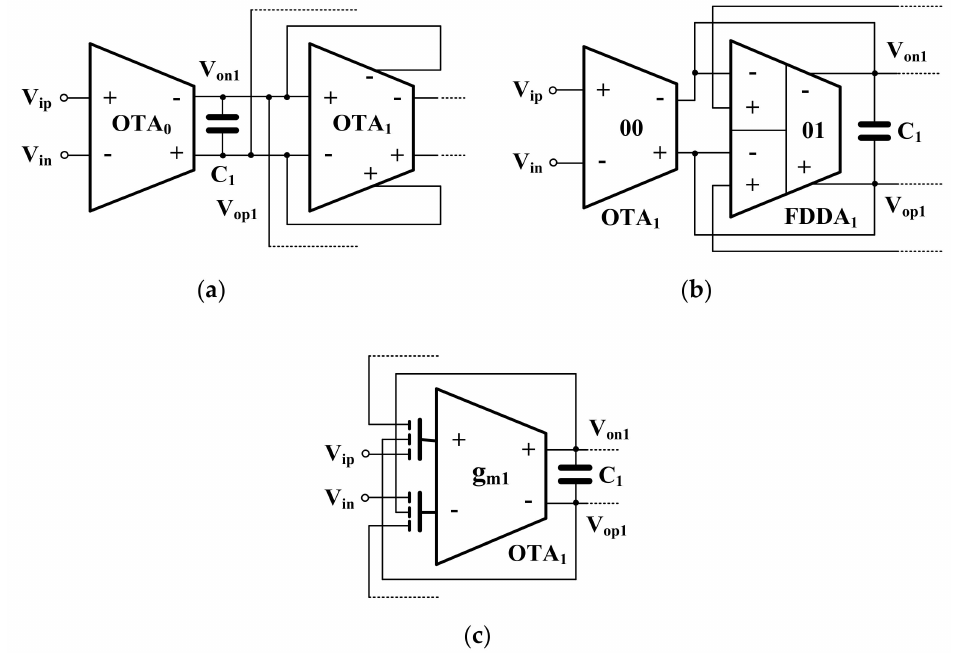
Figure 9. Lossy integrator, ( a ) circuit in [8], ( b ) circuit in [10], ( c ) proposed